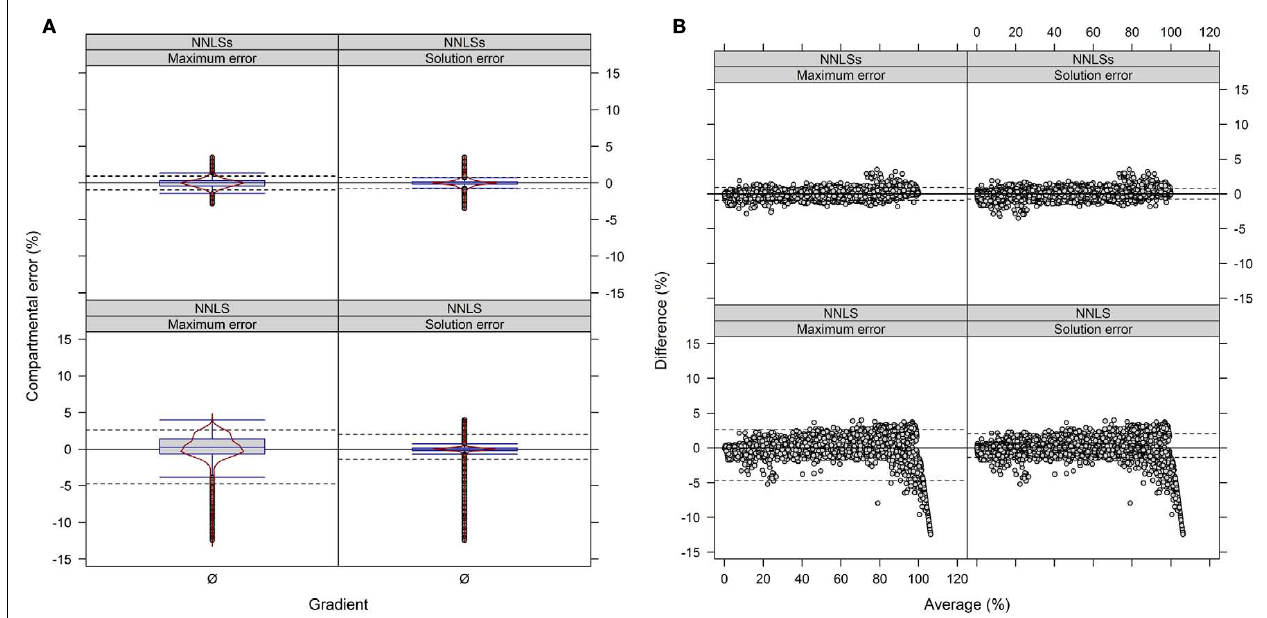
the difference in compartmental abundances between BFA and NNLS or iterative (seed-based) NNLS (NNLSs) are visualized based on the mean–average of compartmental abundances for the three independent gradients.The 5th and 95th percentiles are drawn as black dashed lines. Only values are shown if they are considered as sufficiently explained, i.e., TPD ≤ 10% based on the BFA